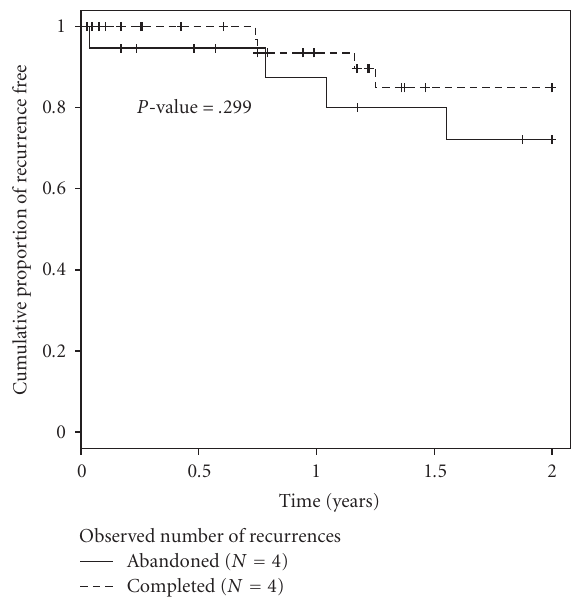
Figure 1: Cumulative probability of recurrence free at two years of followup.